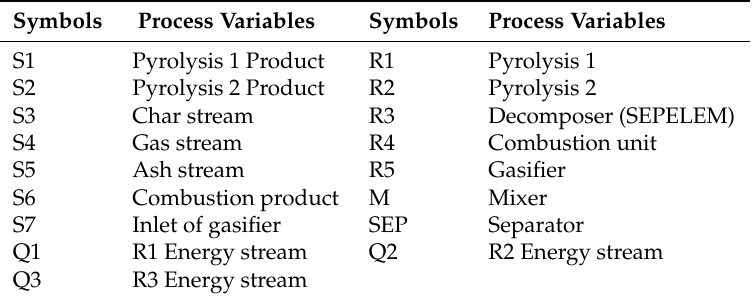
Table 1. Material streams and blocks symbols used in Figure 1.